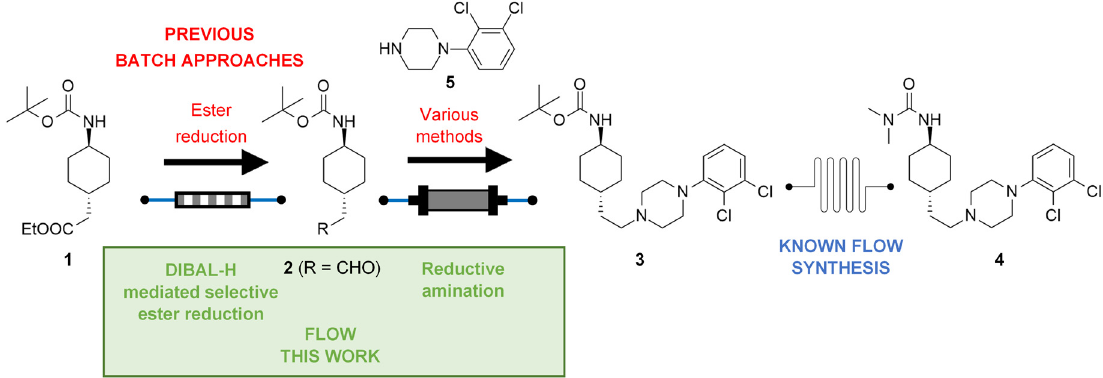
Scheme 1. Synthetic approaches to produce the key intermediate of cariprazine, including the relevant stepwise batch methods. (DIBAL-H: Diisobutylaluminum